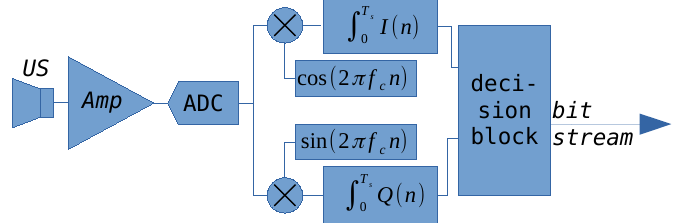
Figure 2. The diagram of QPSK demodulation process. A traditional demodulation algorithm with the use of IQ signals is utilized.